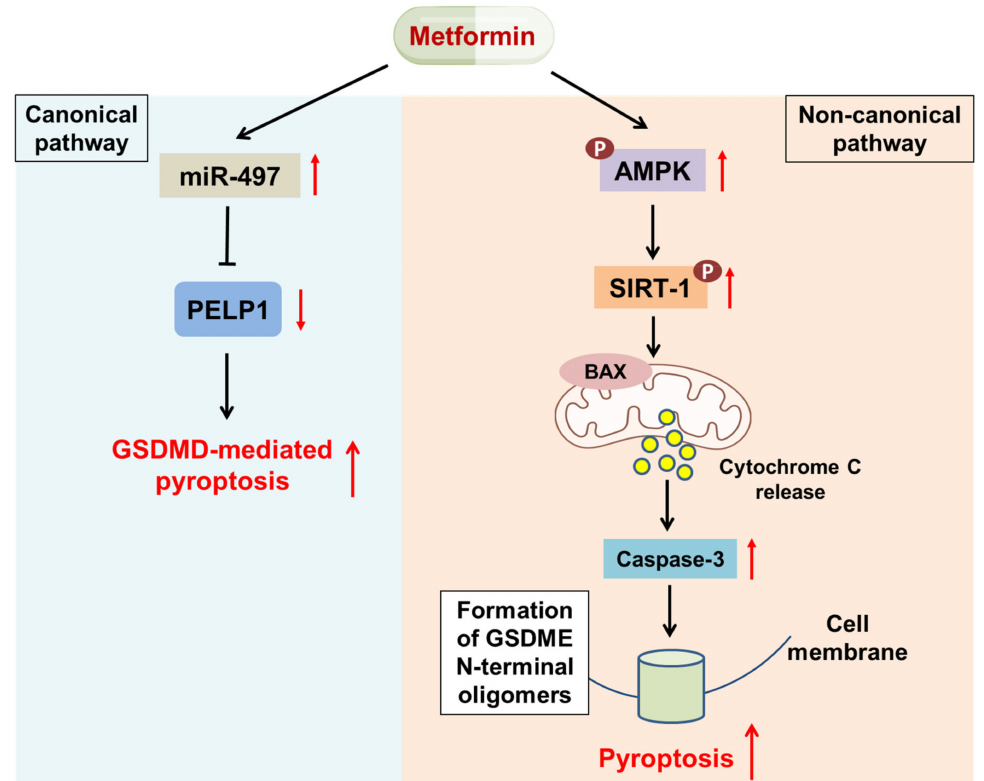
Figure 4. Metformin initiates canonical and noncanonical pyroptosis. Left panel: Canonical pyroptosis: metformin induces GSDMD-mediated pyroptotic cell death via the upregulation of miR-497 and the subsequent inhibition of FELP1. Right panel: Noncanonical pyroptosis: metformin triggers the activation of AMPK, which phosphorylates SIRT-1. This upregulates BAX and promotes the release of cytochrome C from mitochondria, which initiates caspase-3- and GSDME-mediated pyroptotic cell death.